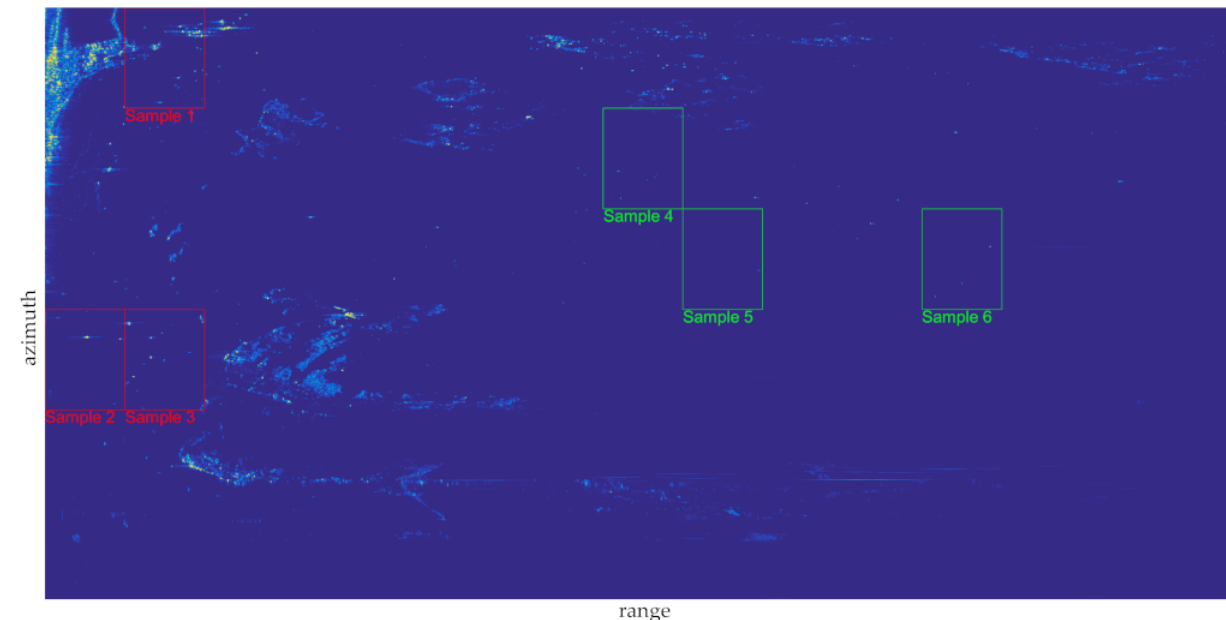
Figure 12. Measured data.